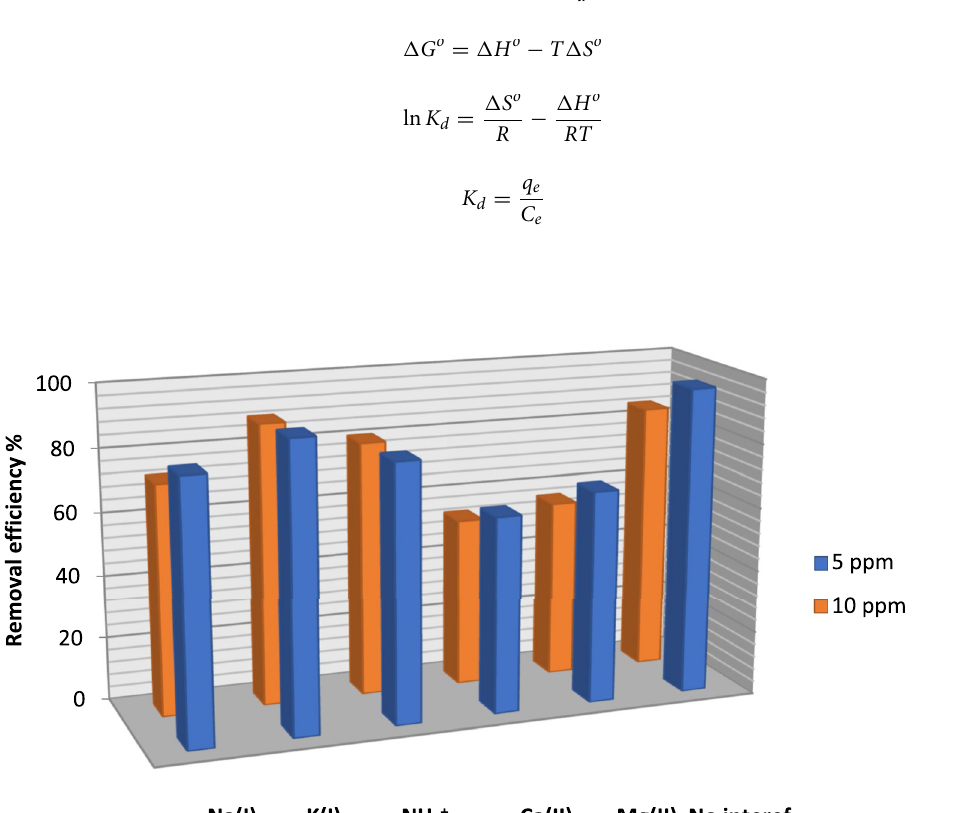
Figure 9. Influence of interfering species on biosorptive removal of BF dye by Gel@GO-F-ZrSiO 4 @Gel. Removal efficiency values (%) are based on triplicate analysis with ±